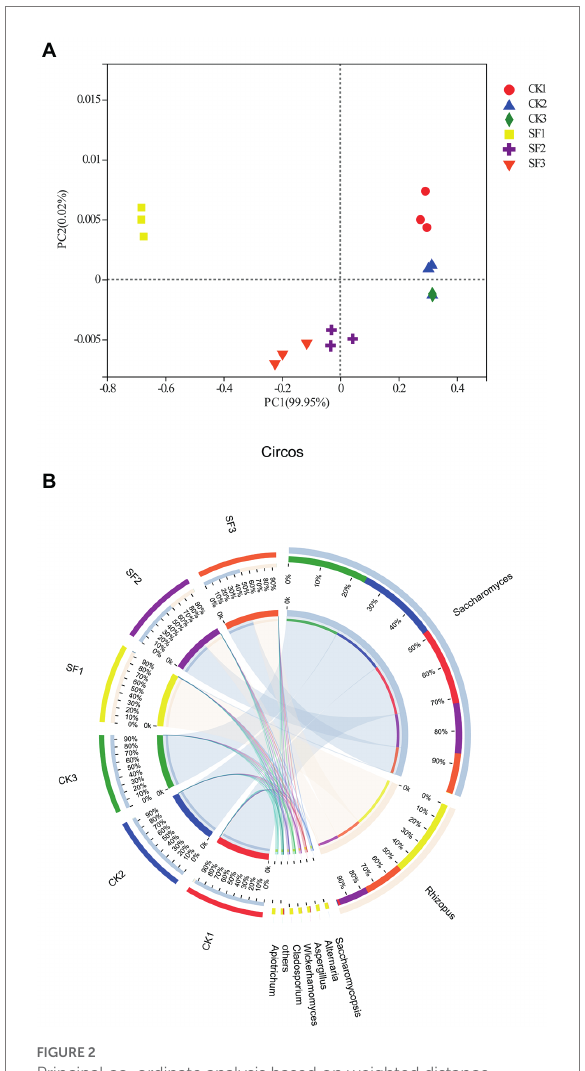
FIGURE 2 Principal co-ordinate analysis based on weighted distance (A) and fungal communities in fermented samples at the genus level (B) .